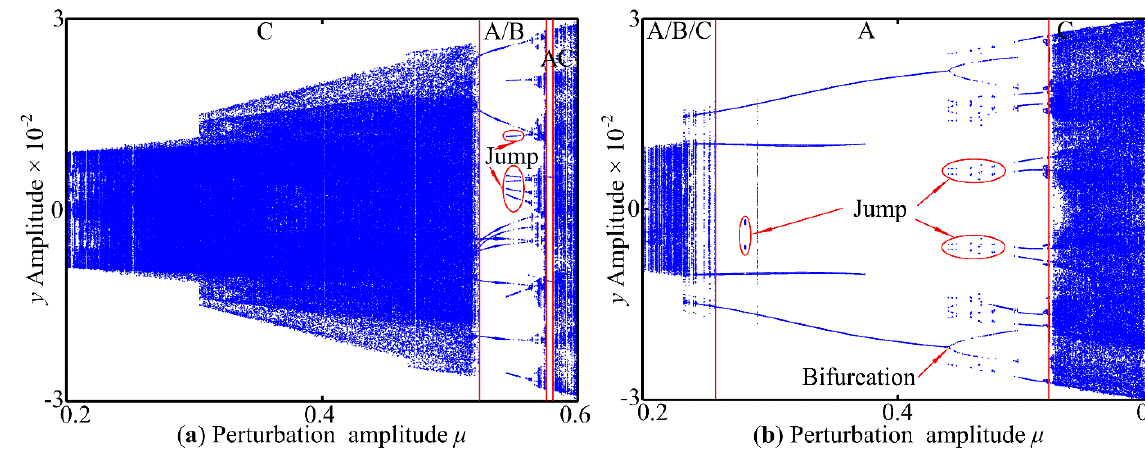
Figure 6. Bifurcation diagram of system response with μ : ( a ) k a = 3.1 × 10 6 , k b = 0; ( b ) k a = 2.6 × 10 6 , k b = 8.6 × 10 6 (A: periodic motion; B: quasi-periodic motion; C: chaotic motion).